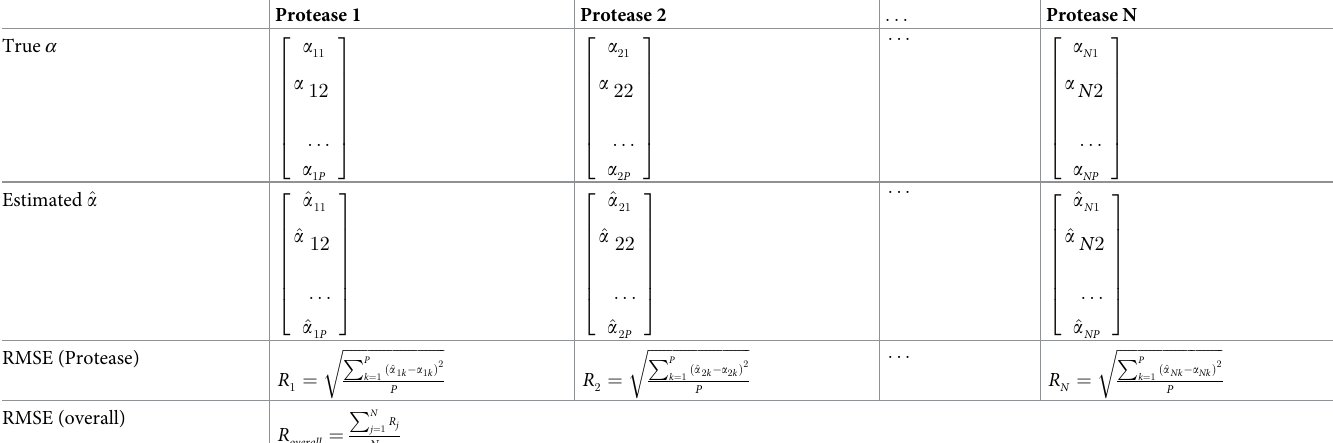
Table 2. The first row is true α in P mixtures, of which each has N proteases. The second row is estimated α . The RMSEs for individual proteases (R 1 , ... , R N ) are calcu- lated in the third row, and the overall RMSE will be the average of all individual RMSEs. In the simulation setting, P is the number of repetitions we applied. The repetition time is P = 200.